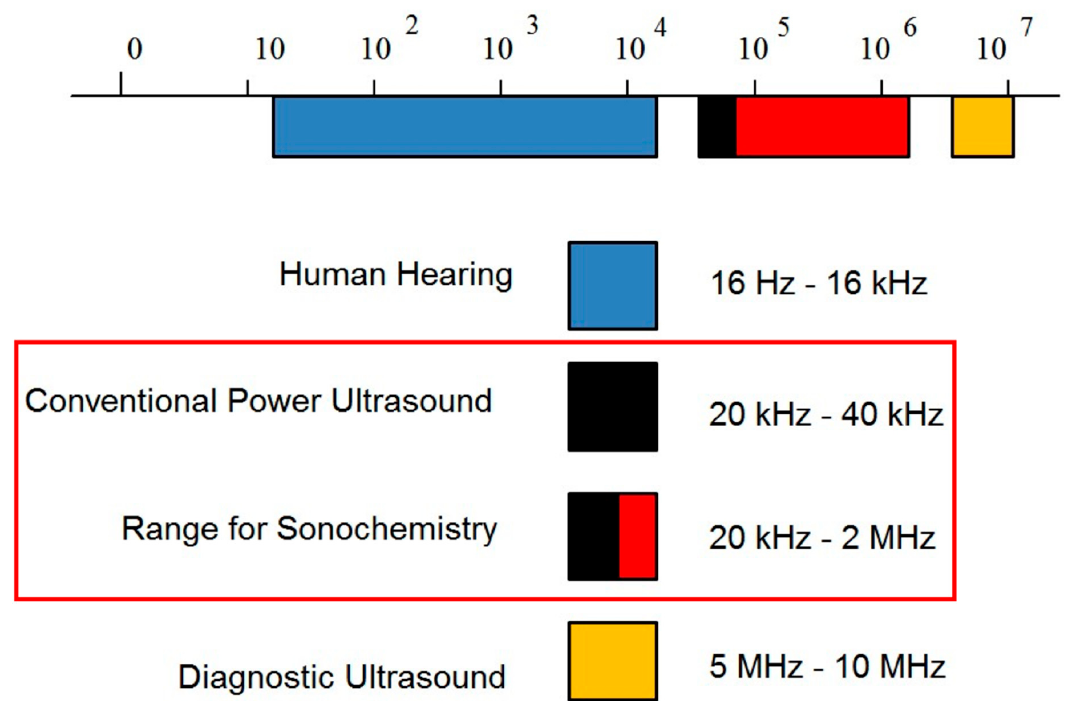
Figure 1. (Ultra)sonic frequency range.